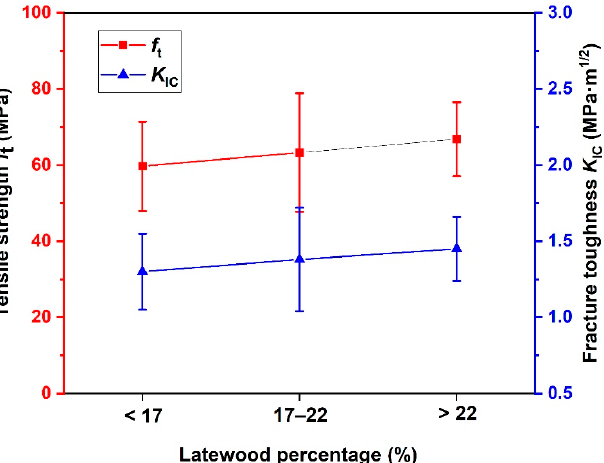
Figure 4. Distribution of the tensile strength and fracture toughness with different volume percentages of the latewood of PSV.